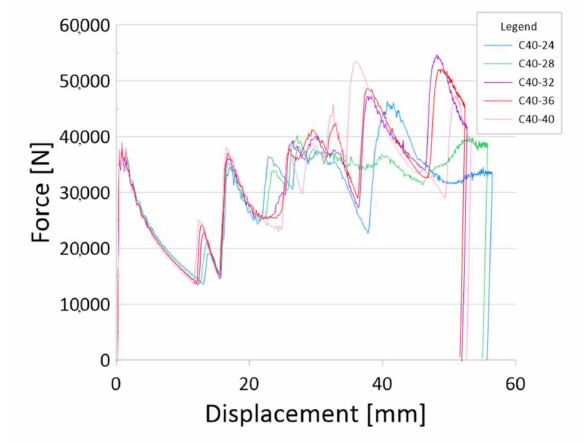
Figure 11. The results for models with a sidewall thickness of 1–4 mm.